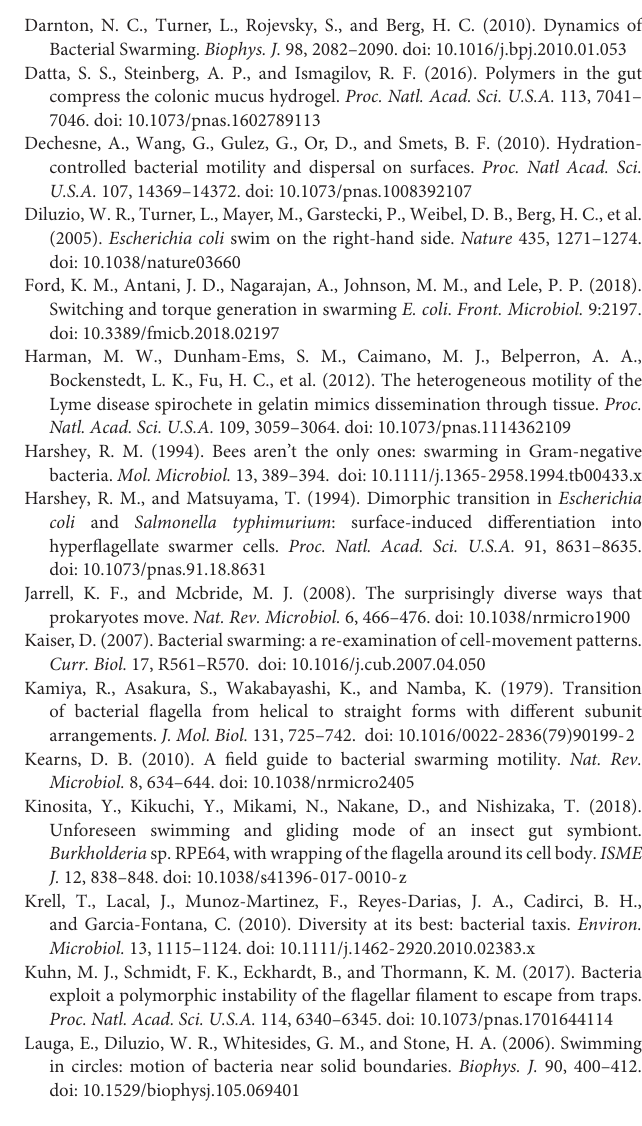
FIGURE S7 | (cid:49) cheY cells in the monolayer region and the multilayer region and the wildtype cells in the monolayer region show the similar average propulsion angle. (A–C) The distribution of the propulsion angles of the (cid:49) cheY swarmer cells in the monolayer region, the multilayer region, and the wildtype swarmer cells in the monolayer region, respectively. The right panel shows the definition of the propulsion angle, with the red dot denoting the head of the cell. FIGURE S8 | Growth curves for E. coli strains HCB1 (wildtype) and HCB1736 ( (cid:49) cheY ) in TB solution (200 r/min shaker, 30 ◦ C). Two strains showed near-identical growth rate. FIGURE S9 | Mean squared displacements of HCB1 (wildtype, blue circles) and HCB1736 ( (cid:49) cheY , red circles), both exhibiting normal diffusive behavior, with linear relationship between MSD and time. FIGURE S10 | Distribution of waiting times between turns showing an exponential shape regardless of the choice of cutoff angular speed. (A,B) The result of HCB1 (wildtype) and HCB1736 ( (cid:49) cheY ), respectively. The solid lines represent the results of exponential fitting. FIGURE S11 | Distribution of the reversal angles for HCB1736 ( (cid:49) cheY ) swarming. frame rate of 80 fps and played at 25